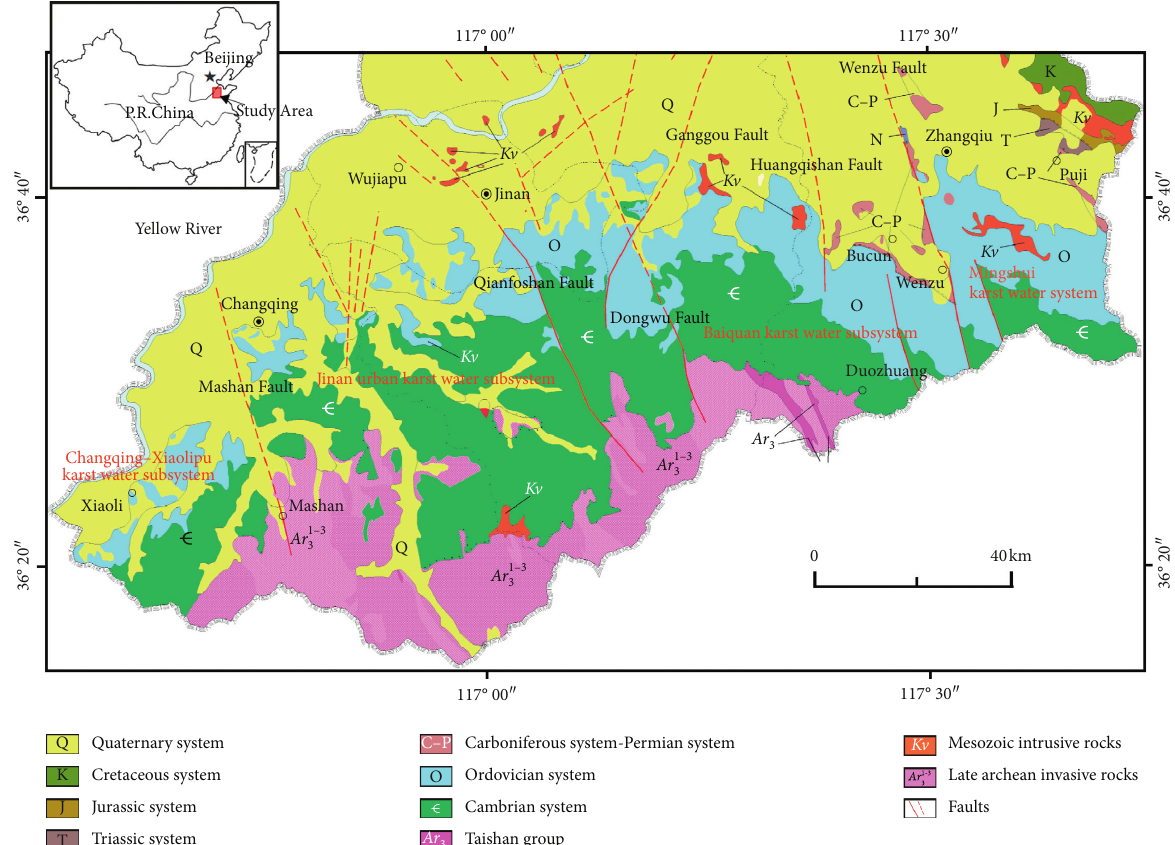
Figure 1: General map of the study area and the division of karst water